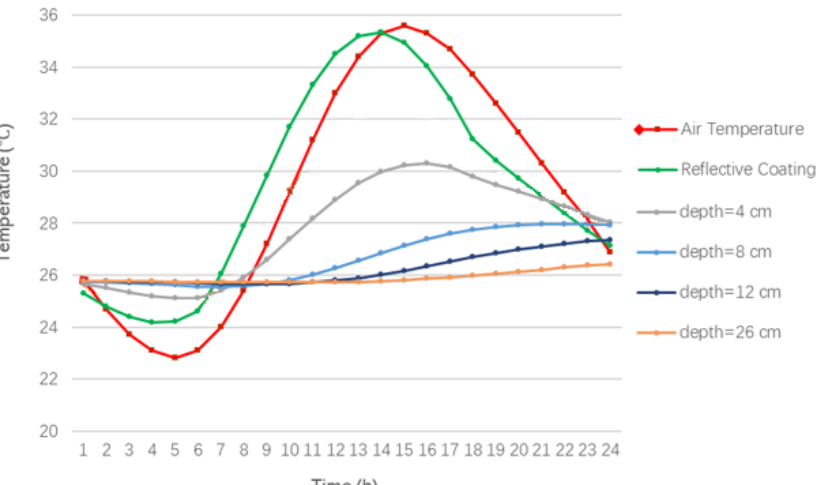
Figure 9. Hourly air temperature and temperature of the asphalt layers of the cool pavement at different depths in the summer.